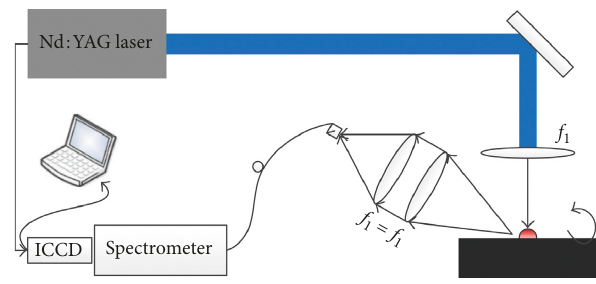
Figure 1: Diagram of a typical LIBS experimental setup for studying geological samples. Table 1: Description of geological samples used in this